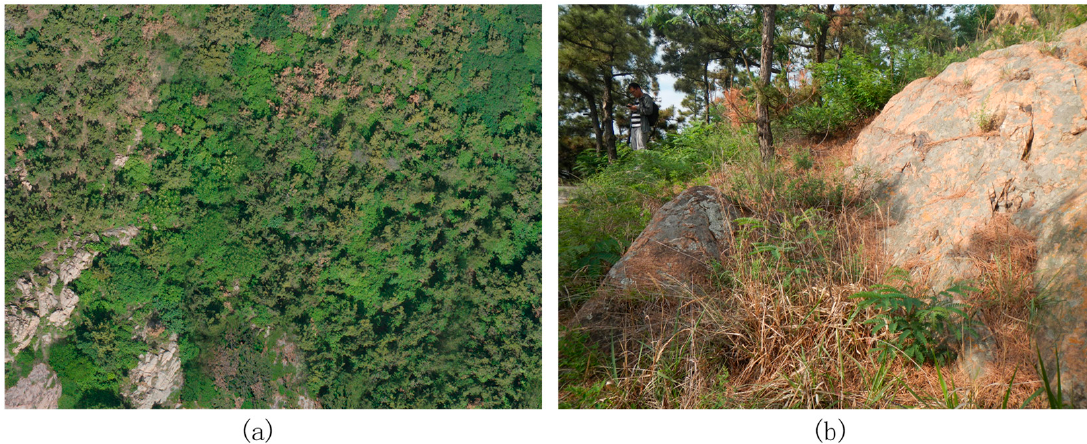
Figure 4. The test area with a more complex background. ( a ) UAV image; ( b ) Field image.